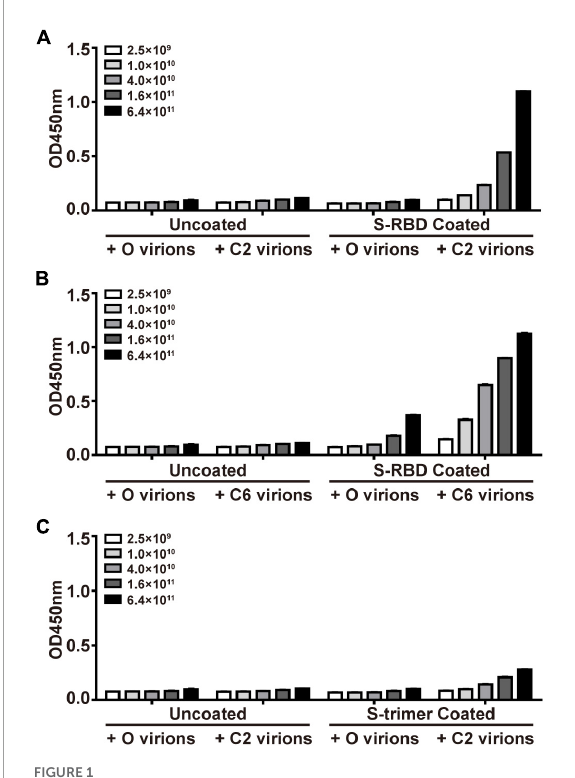
FIGURE1 Confirmation of affinity binding of phages of S-protein Entrapped Affinity Ligand (SEAL) sequences with recombinant spike-receptor-binding domain (S-RBD) (A,B) or S-trimer proteins (C) . The plates were coated with S-RBD (10 µ g/ml, i.e., about 0.33 µ M, A,B ) or S-trimer proteins (10 µ g/ml, i.e., about 0.073 µ M, C ). The interest phages (C2 and C6) and starting library phages (O) were serially diluted and tested for binding. The apparent less efficient C2 virions to bind S-trimer (C) than to bind S-RBD (A) might be due to these two targets’ difference in molar concentrations (by about 4.4-fold) at the same mass